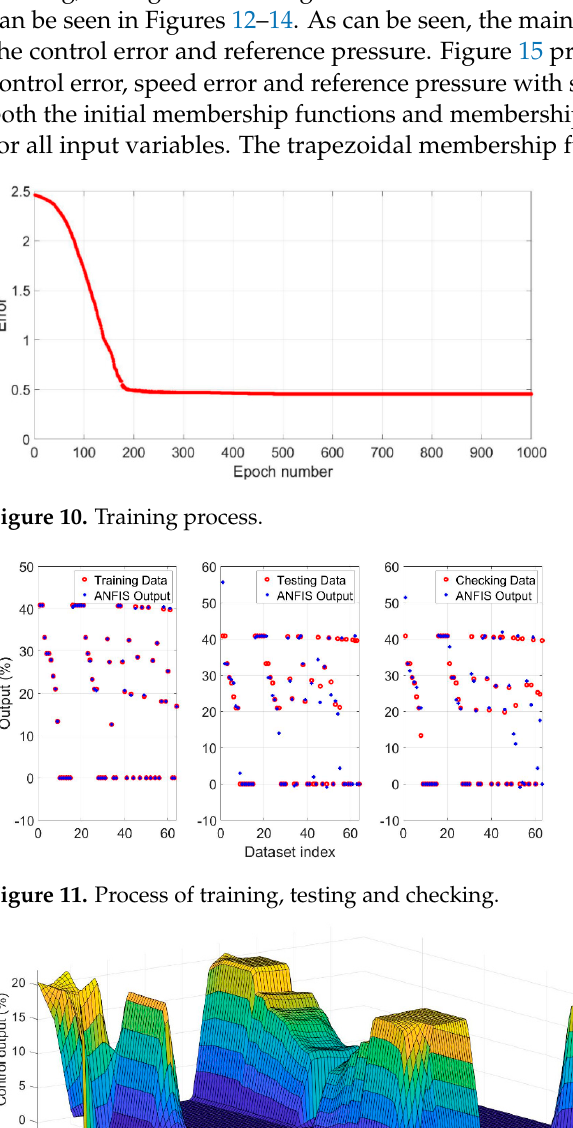
Figure 12. Influence of control error and speed error on final control output.